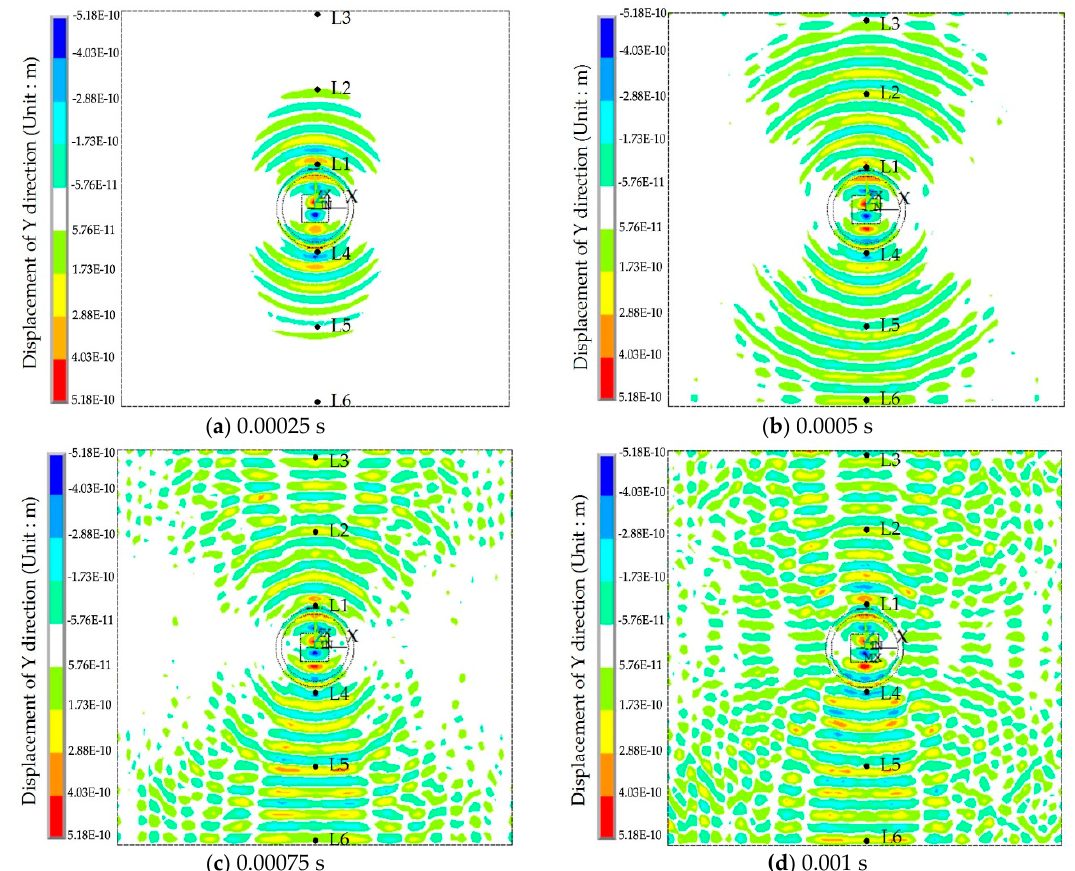
Figure 9. The displacement contour diagram at the 100% grouting level.